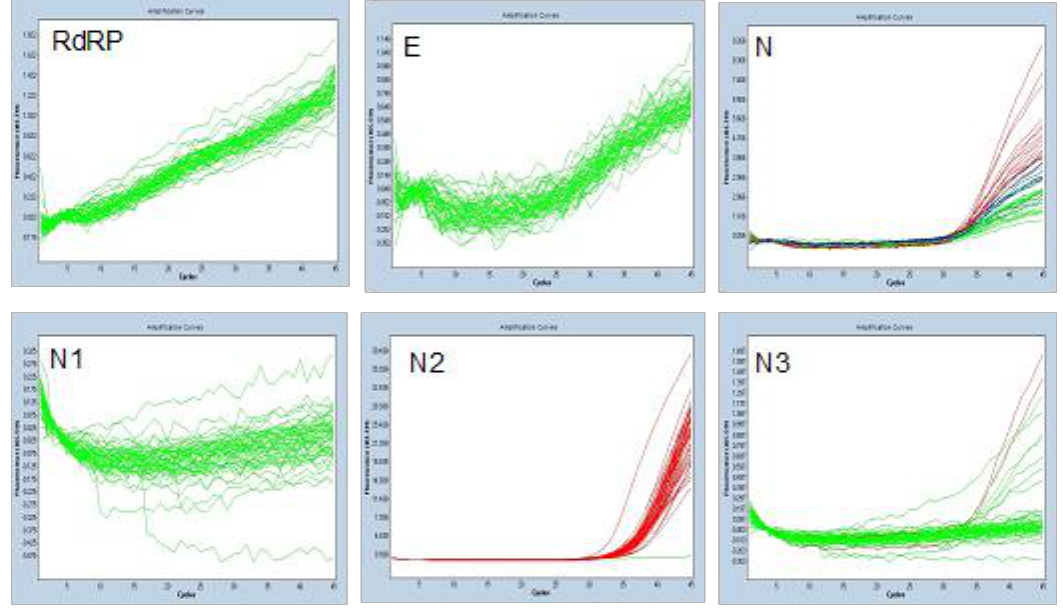
Figure 1. Assays’ analytical specificity analysis. N, N2, and N3 were excluded from the validation due to lack of analytical specificity when applied to nasopharyngeal samples of healthy volunteers. Rayon ( n = 30) and cotton ( n = 30) swabs were used for the nasopharyngeal sample collection for